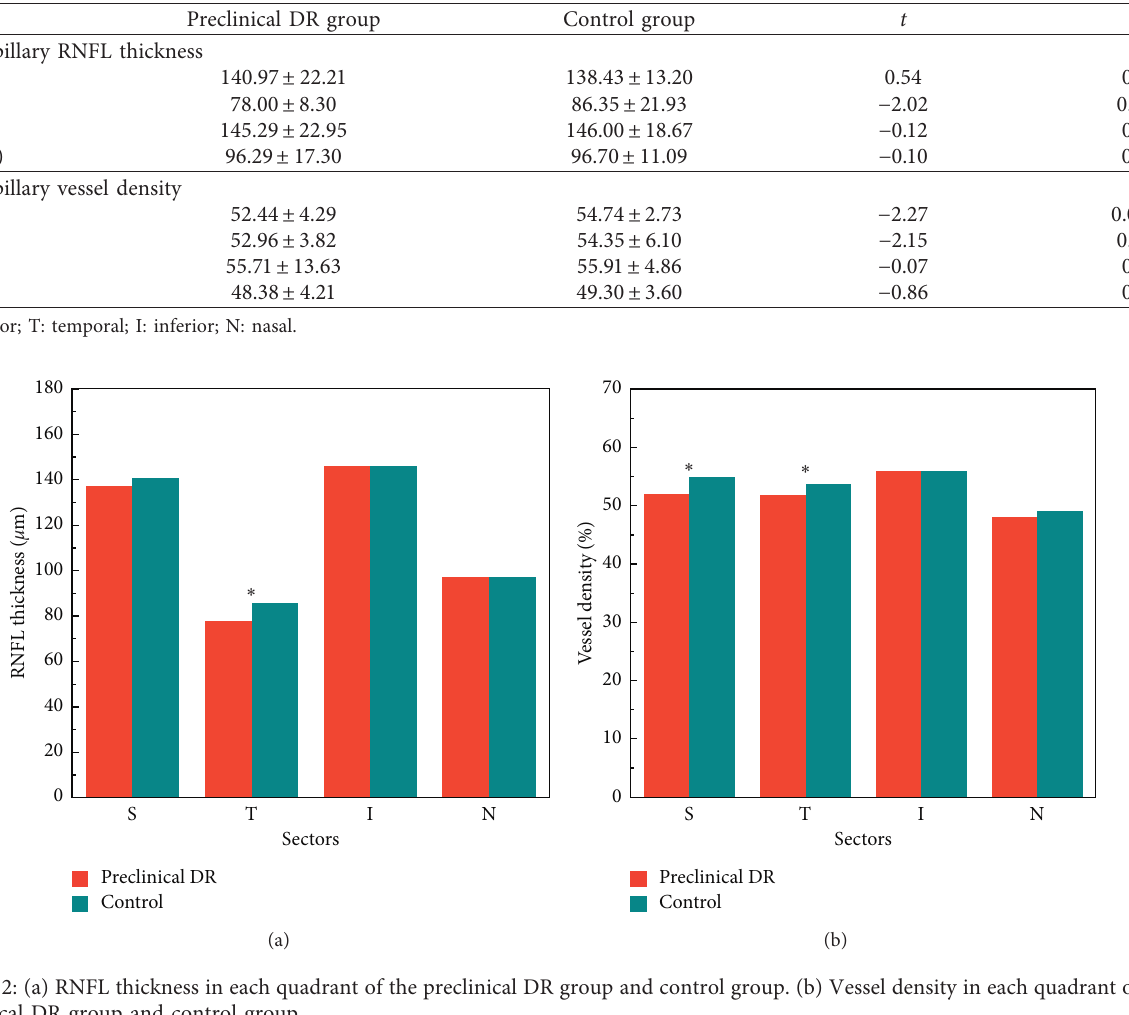
Table 3: RNFL thickness and vessel density in each